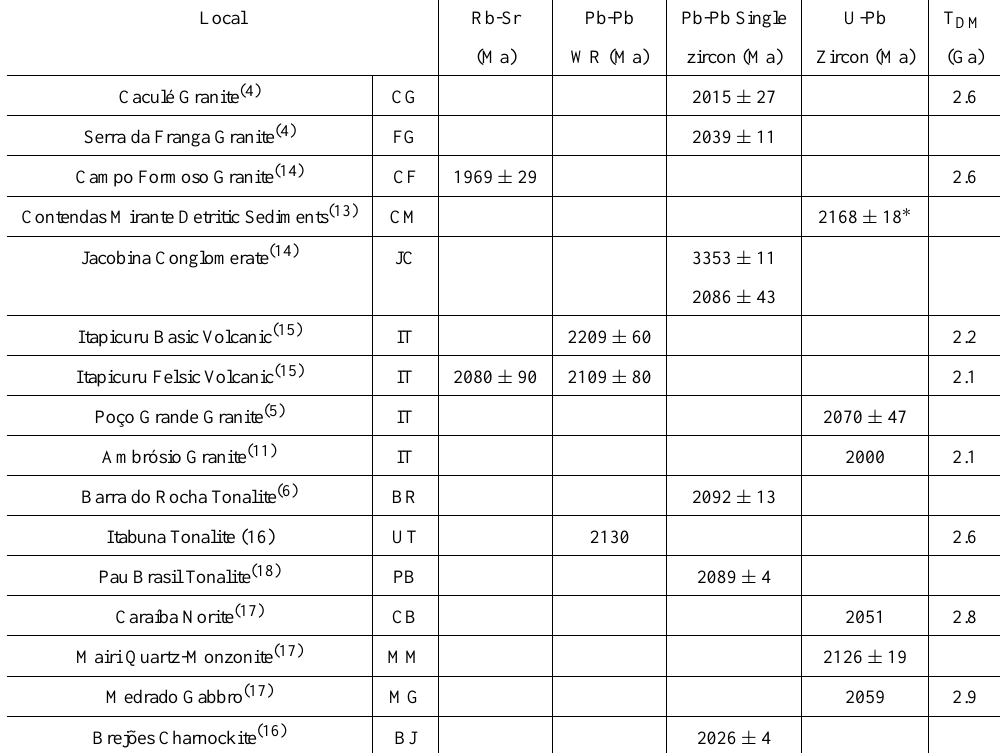
Gavião, Jequié and Serrinha blocks and Itabuna-Salvador-Curaçá Belt. Ages of the Archean main plu- tonic and supracrustal rocks according to different radiometric methods. Gaal et al. (1987) (11), Ledru et al. (1993) (6), Santos Pinto (1996) (4), Bastos Leal (1998) (5), Nutman et al. 1994 (13), Mougeot (1996) (14), Silva (1987) (15), Barbosa et al., in preparation (16), Oliveira and Lafon (1995) (17), Corrêa Gomes (2000) (18). Asterisks represent SHRIMP geochronological data. WR = Whole Rock. Local Rb-Sr Pb-Pb Pb-Pb Single U-Pb